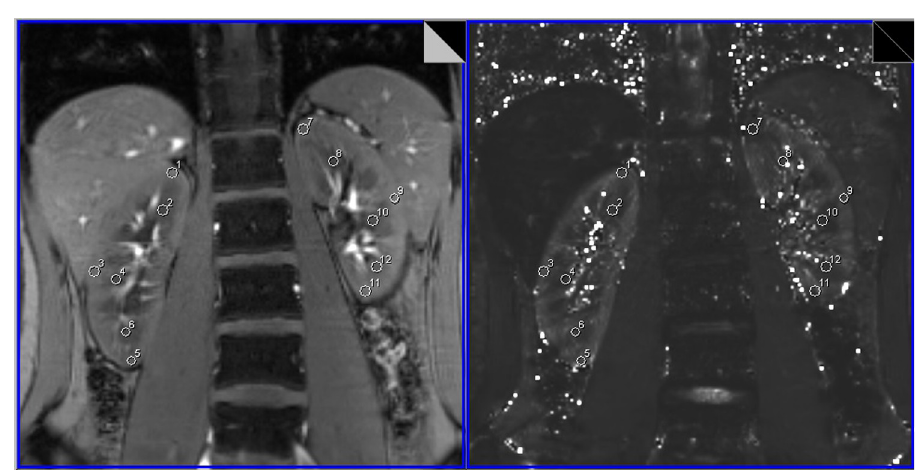
Fig 1. Regions of interest (ROIs) in the original blood oxygen level–dependent magnetic resonance image, which showed a clear anatomical structure after pairing with the corresponding T2 � mapping image. ROIs were projected automatically to the T2 � mapping